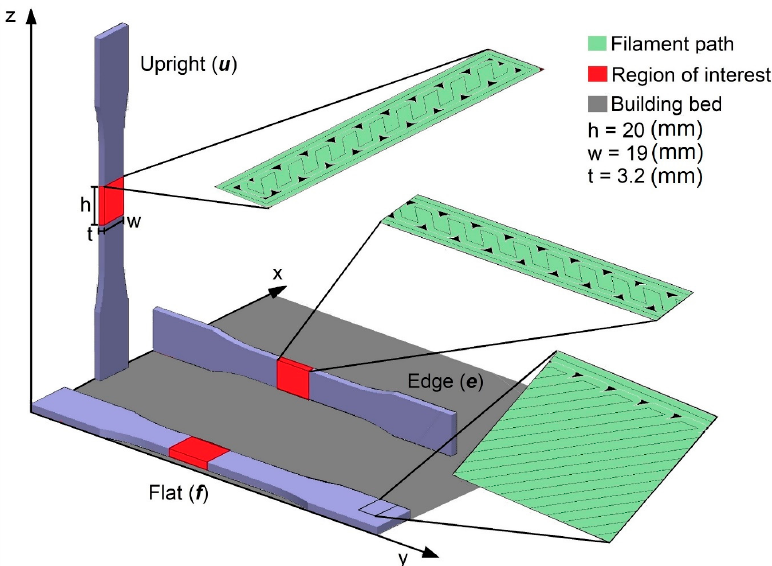
Figure 2. Built samples in flat, edge, and upright orientations based on ASTM D638 type 1, showing the filament path in green, regions of interest in red, with a size of 20 × 19 × 3.2 mm 3 , and building bed in dark gray. the filament path in green, regions of interest in red, with a size of 20 in dark